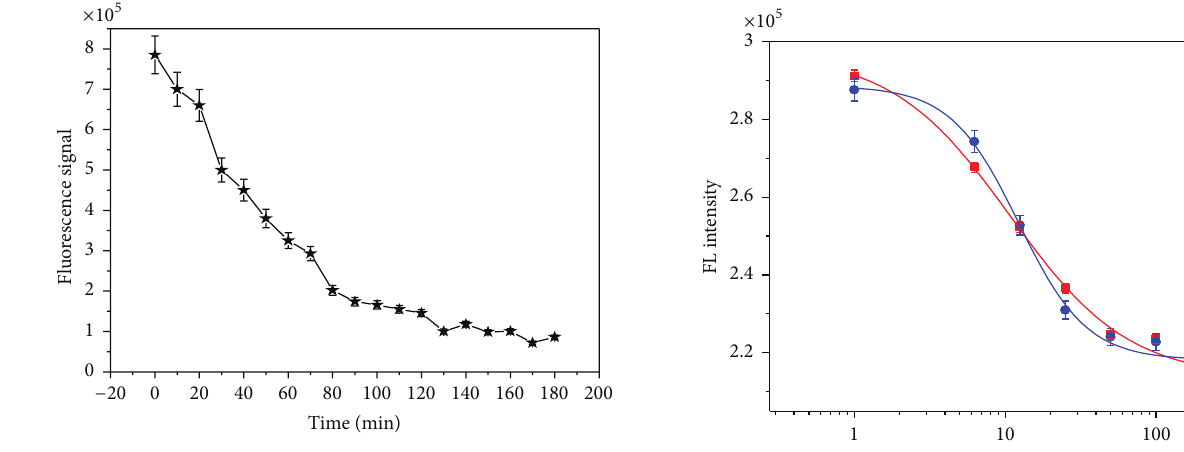
Figure 4: Optimization of incubation time for FITC conjugated 2 ∘ Ab. 1 ∘ Ab dilution, 1: 16000; FITC conjugated 2 ∘ Ab dilution, 1:64000; excitation time, 0.1s.